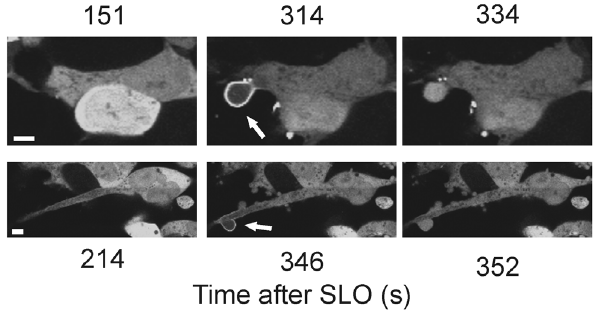
Figure 5. The plasmalemmal repair of SLO pores occurs in lysosome-free blebs. SLO-induced plasmalemmal translocation/ cytoplasmic back-translocation of annexin A1-YFP marks the successful elimination of the SLO-pores in blebs of HEK 293 cells. Arrows denote the plasmalemmal translocation of annexin A1 (plasmalemmal permea- bilization). Magnification bars=5 m m. Figure 6A (Video S7) shows a toxin-perforated SH-SY5Y cell. The toxin-induced Ca 2 + -elevation leads to a contraction of the cell’s